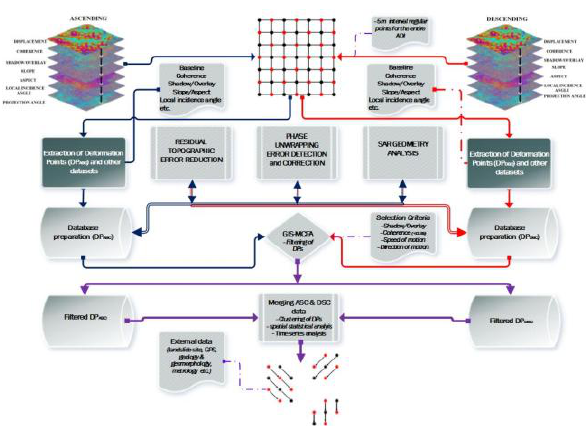
Figure 2. The workflow of data